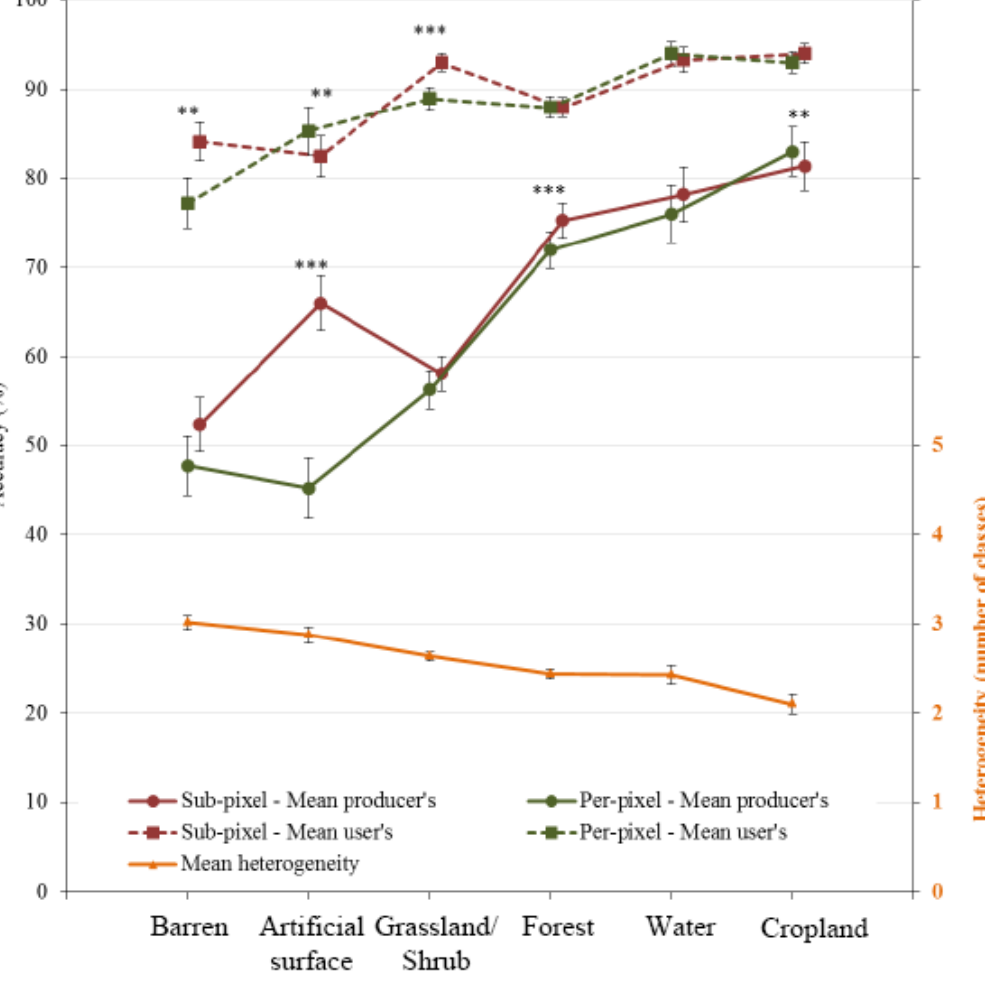
Figure 3. The mean producer’s and user’s accuracies of per-pixel and sub-pixel classification methods together with the mean number of classes across all 3 × 3 pixels “soft” validation samples. The mean of producer’s and user’s accuracies were calculated as the averages of all producer’s and user’s accuracies taken from the individual cross tabulation matrices developed for all “soft” validation samples. The error bars represent one standard error. The asterisks indicate * p < 0.05, ** p < 0.01 and *** p < 0.001 from the Wilcoxon signed-rank